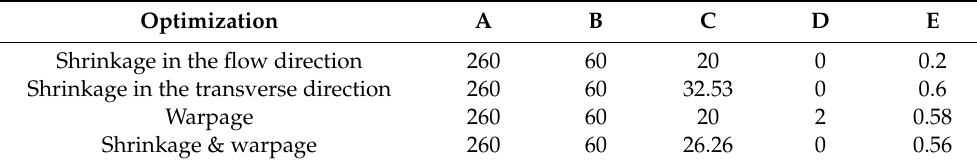
Table 9. Optimum condition by response surface methodology.